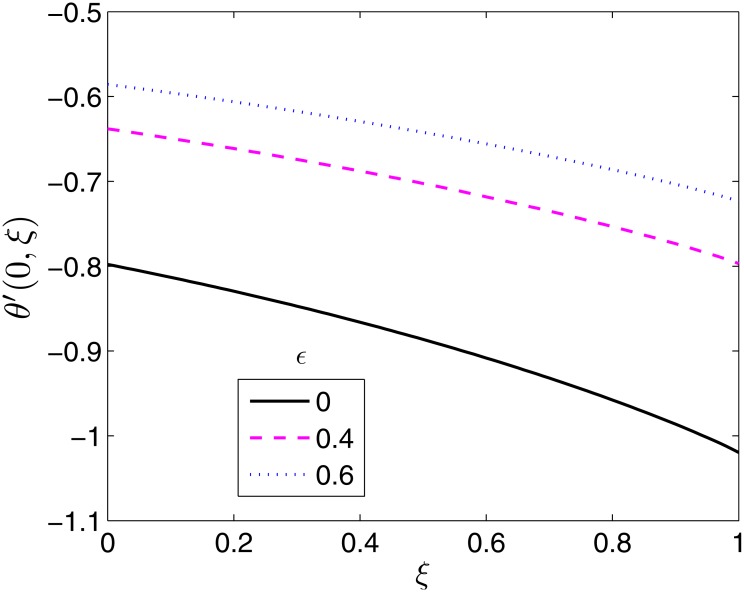
Effect of Pr on θ′(0, ξ).
β = 0.5, β
1 = 0.5, β
2 = 1ϵ = 0.1, S = 0.2.